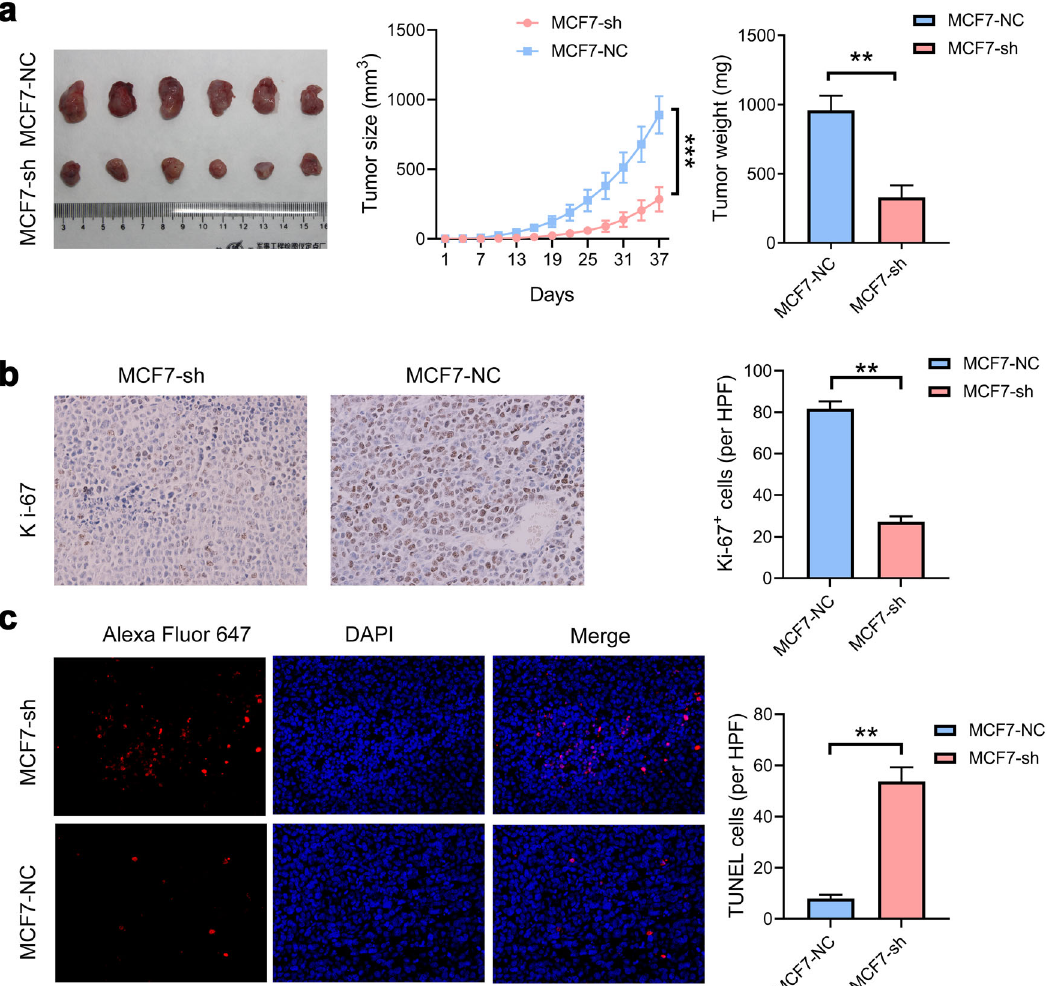
Fig. 3 MIR200CHG promotes tumor formation in nude mice xenograft models. a Representative images of tumors from the MCF7-sh and MCF7-NC cell lines. The volumes and weights of the subcutaneous xenograft tumors ( n = 6) are indicated. Tumor volumes were calculated after injection every 3 days. Data are represented as mean ± SD and were analyzed by two-way ANOVA. ** P < 0.01, *** P < 0.001. b , c Representative staining images showing the expression levels of Ki-67 and TUNEL in the MCF7-sh and MCF7-NC groups (×400). Data show the mean ± SD of TUNEL and Ki-67 positive cells in fi ve random high-power fi elds (HPF), and were analyzed by two-tailed T test. ** P <